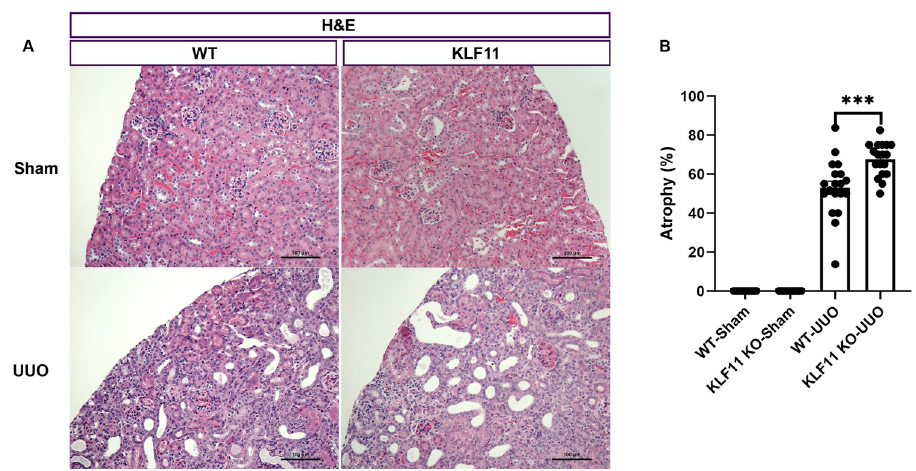
Fig 2. KLF11 deficiency exacerbates renal damage in the murine unilateral ureteral obstruction (UUO) model. (A) Representative histological images of H&E-stained kidney sections at 200 X magnification, showing WT and KLF11 KO at 9 days after the UUO/Sham surgery. Scale bar represents 100 microns. (B) Semiquantitative analysis of tubular atrophy. ��� p � 0.001. Values are means ± SEM.